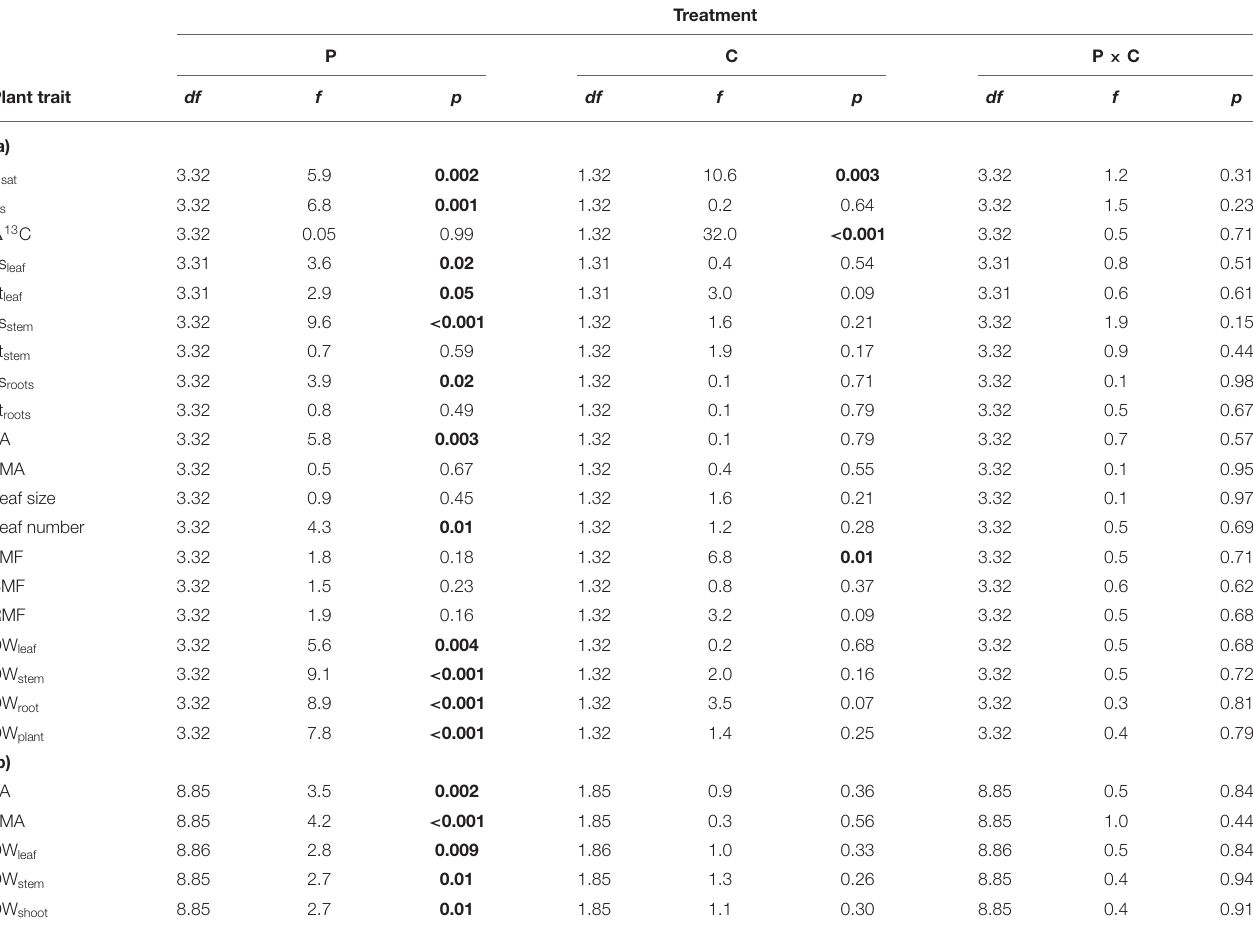
TABLE 7 | Statistical results with degrees of freedom ( df ), f -values ( f ), and p -values ( p ) for Analysis of Variance (ANOVA) for E. grandis . Treatment P C P × C Plant